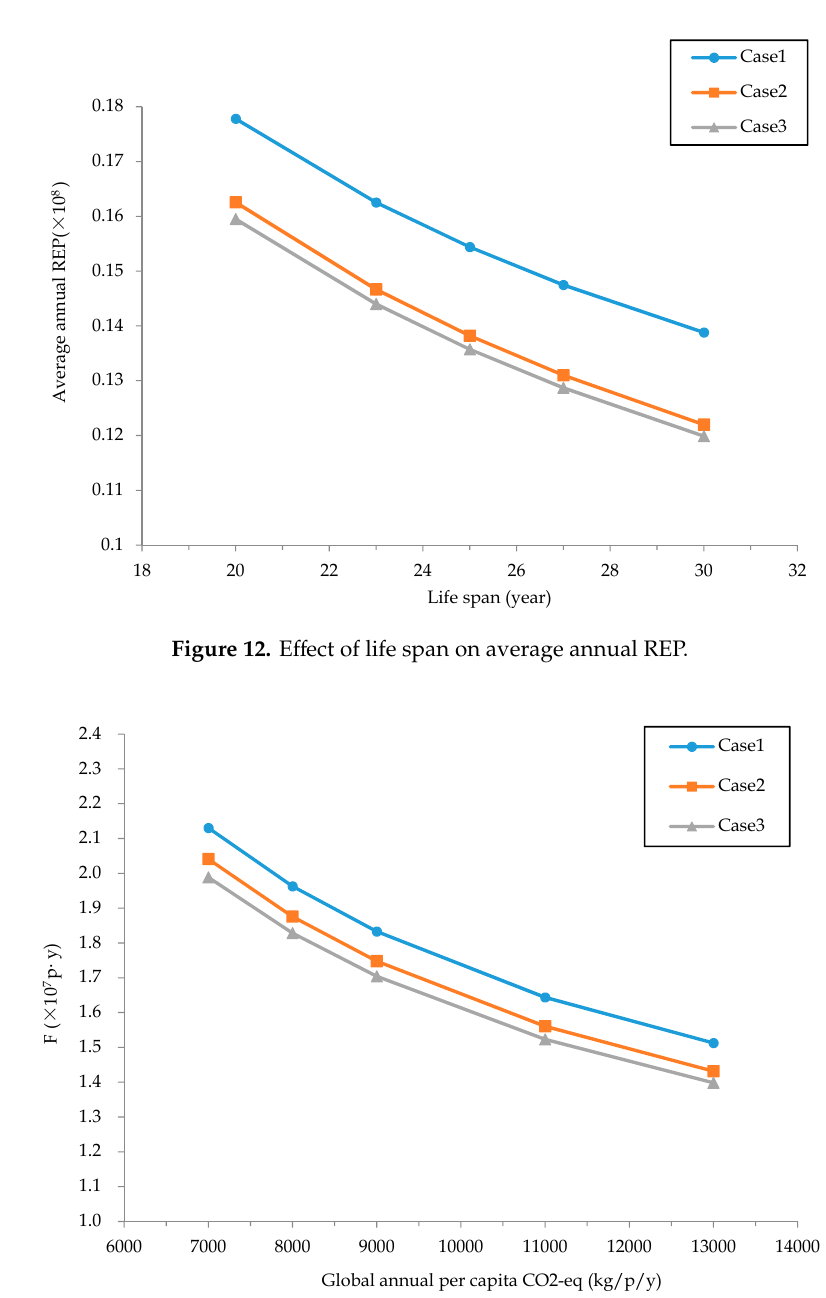
Figure 13. E ff ect of global annual per capita CO 2 -eq on Figure 13. Effect of global annual per capita CO 2 -eq on F.